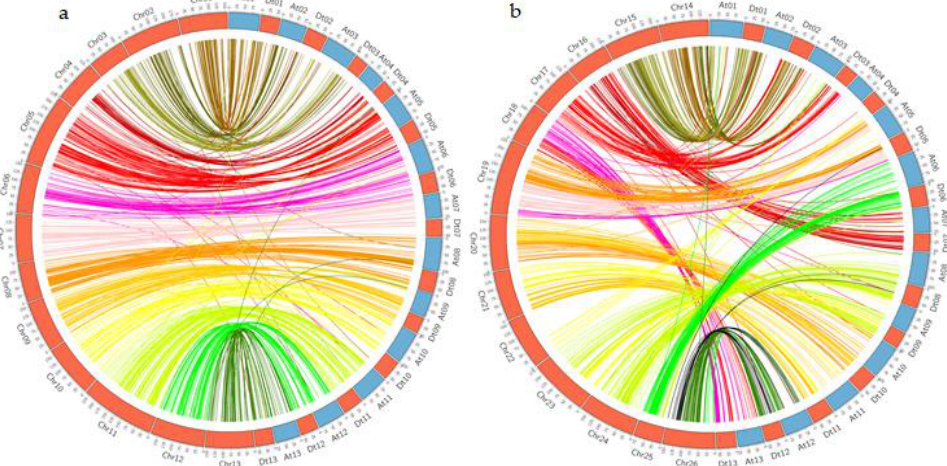
Figure 1. Collinearity relationship between genetic and physical map of G. hirsutum . ( a ) Shows collinearity for chromosomes 1 – 13 and ( b ) shows collinearity for chromosomes 14 – 26 of G. hirsutum .